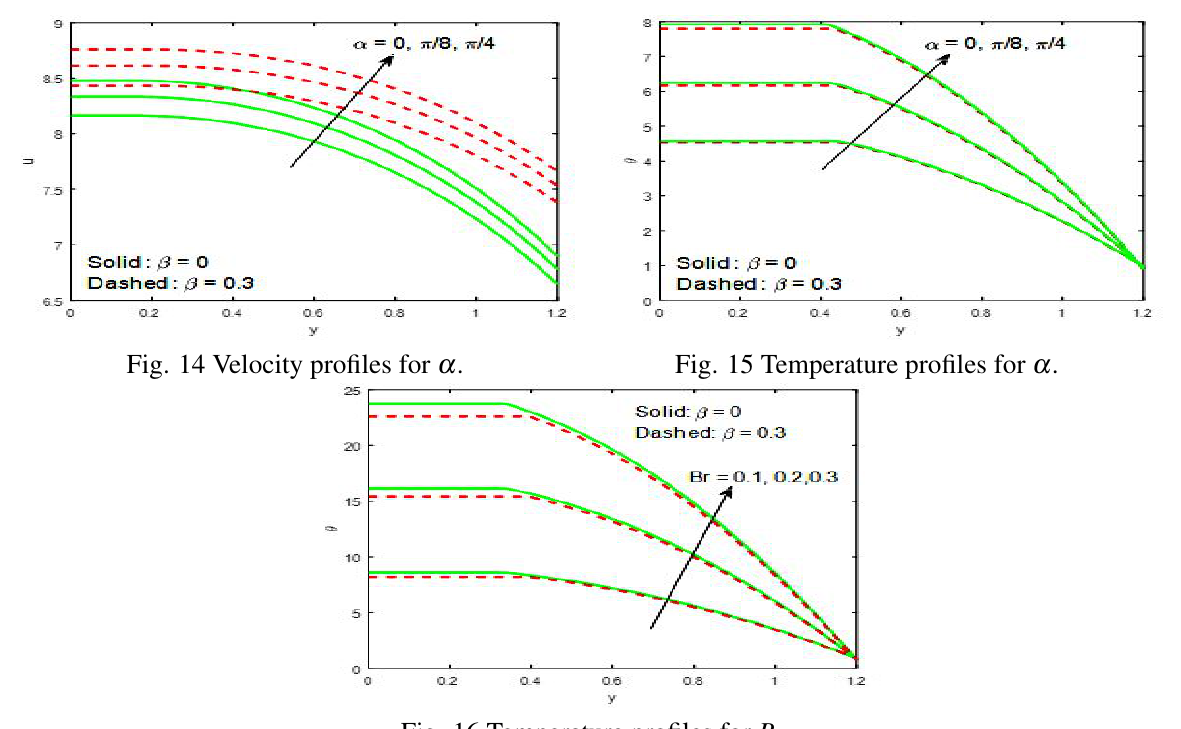
Fig. 16 Temperature profiles for Br